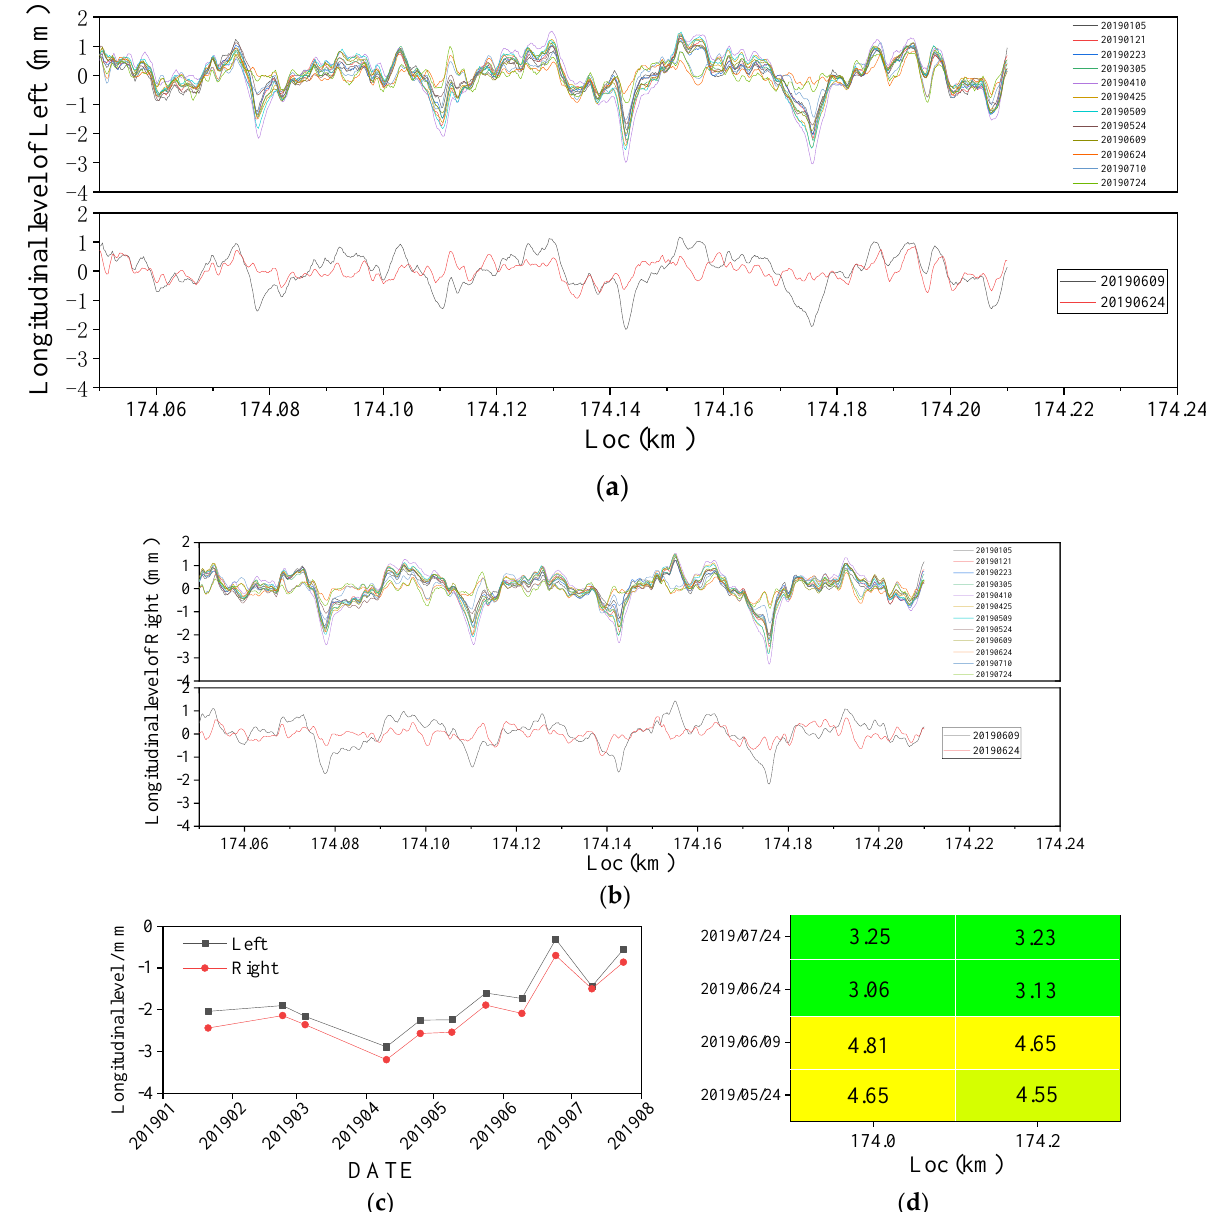
Loc (km) Figure 26. Curve of track longitudinal level of a HSR line. 201301 201303 201305 201307 201309 201311 201401 201403 201405 201407 201409 201411 201501 201503 201505 201507 201509 201511 201601 201603 201605 201607 201609 201611 201701 -6-5-4-3-2-10 12 L o n g i t ud i n a l l e v e l / m m DATE Left Right Figure 27. Variation curve of track longitudinal level with time at 177.034 km of a HSR line. Through field investigation, from June 9 to 24, 2019, the engineering department car-